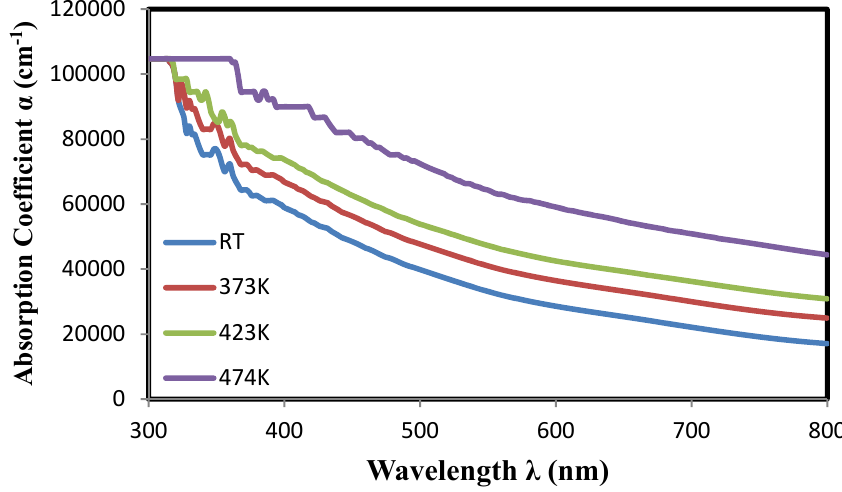
Fig. 4: The variation of absorption coefficient with wavelength for NiO